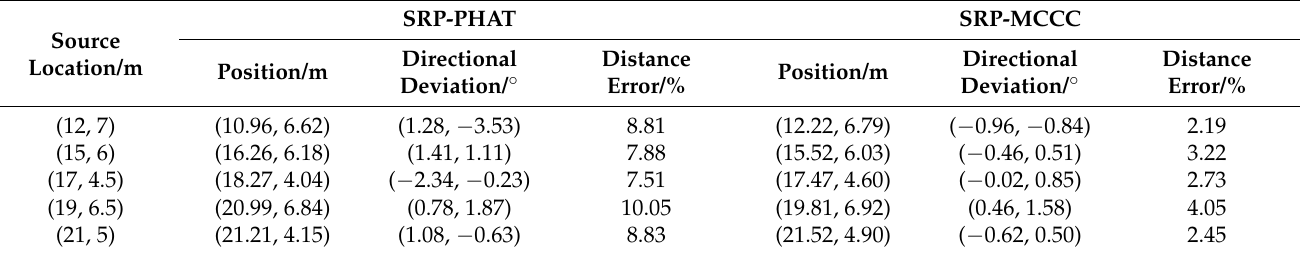
Table 2. Simulation results for different source locations (SNR = − 10 dB, 600 Hz).